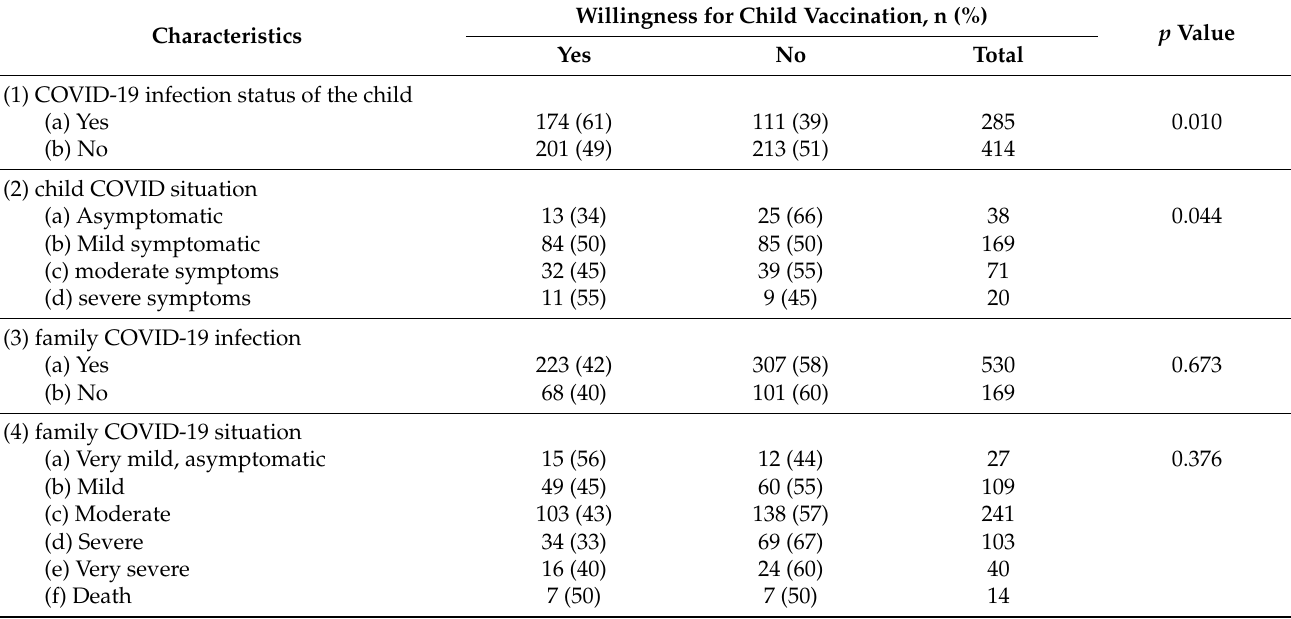
Table 4. Comparison of willingness for child vaccination with COVID-19 infection status. Characteristics